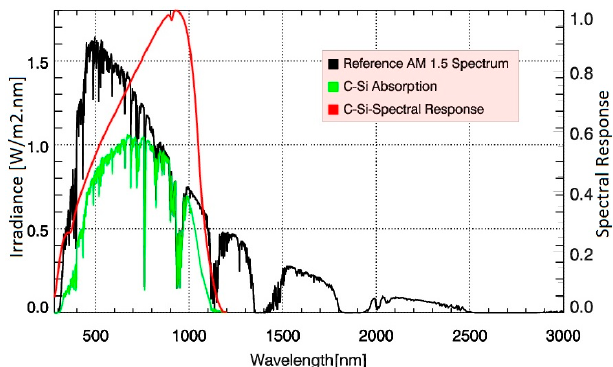
Figure 2. Global solar spectrum at air mass 1.5 (black) and the portion absorbed by a silicon device (green). The silicon sensors (SiS) can measure up to 1200 nm (compare the c-Si spectral response (red)), while the pyranometer measures up to about 2800 nm.